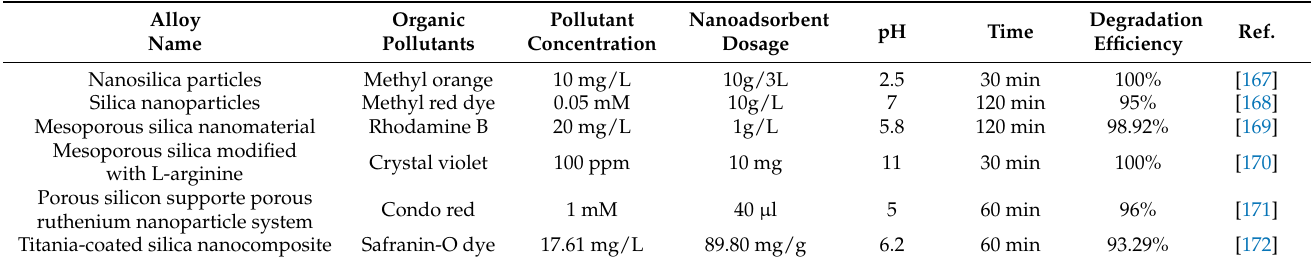
Table 7. Azo dye degradation with silica-based nanoadsorbents.